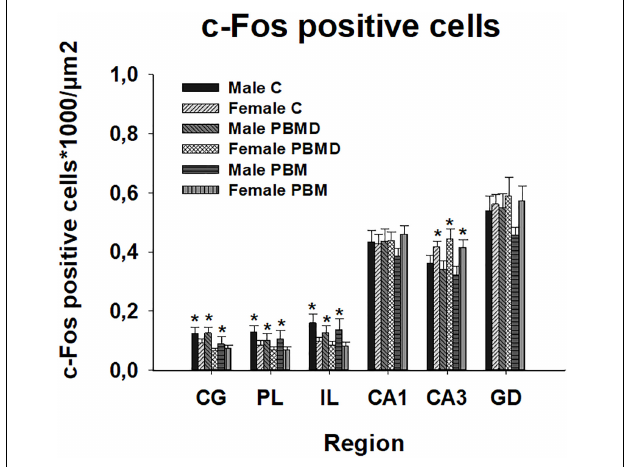
FIGURE 6 | c-Fos positive cells (positive cells of c-Fos/ µ m 2 ) differences between sexes in the three groups (PBM, PBMD, and C) in each region of interest (mean ± SEM). Male groups showed more c-Fos positive cells in the prefrontal cortex (CG, IL, and PL) (* p < 0.05) while female groups showed higher c-Fos expression in CA3 (* p < 0.05). Groups: C, control group; PBMD, photobiomodulation device group; PBM, photobiomodulation group. Areas: CG, Cingulate cortex; PL, Prelimbic cortex; IL, Infralimbic cortex; CA1, field CA1 of hippocampus; CA3, field CA3 of hippocampus; DG, Dentate Gyrus.